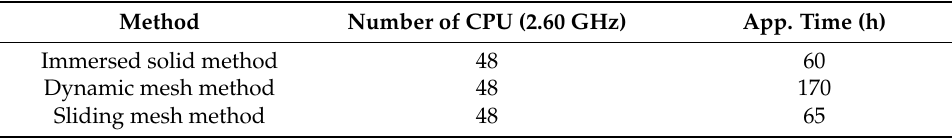
Table 1. Computational resources and time allocated to the